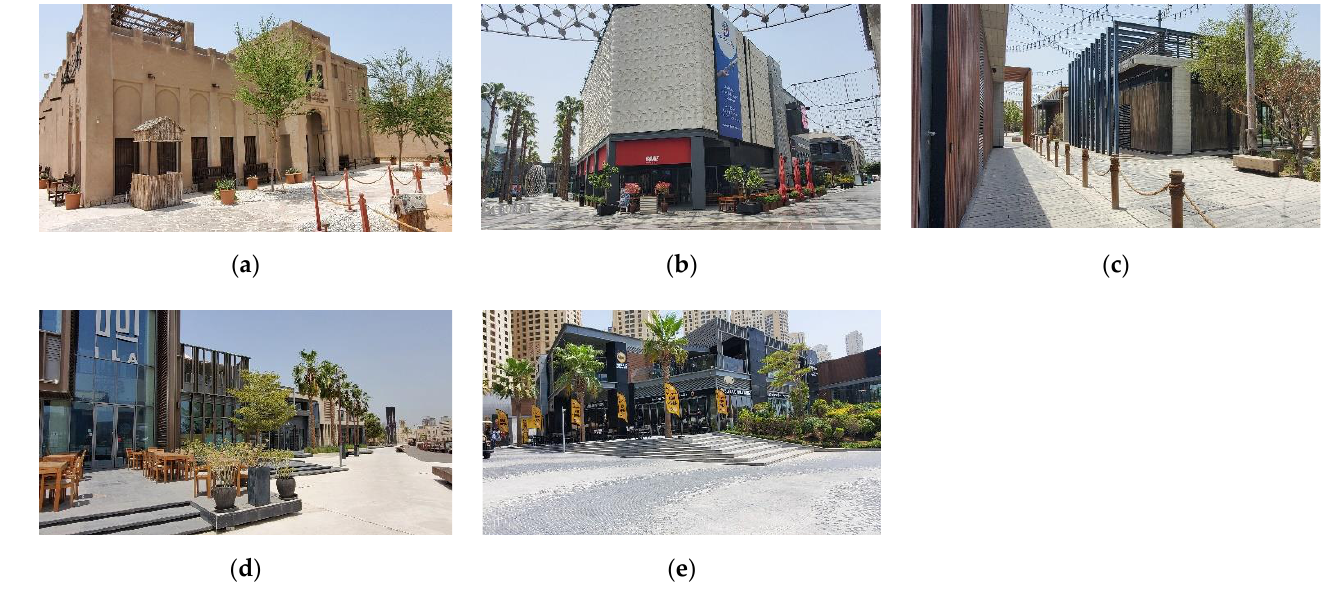
Figure 1. Historical and modern built environments in Dubai. All images taken by author, 2022. ( a )